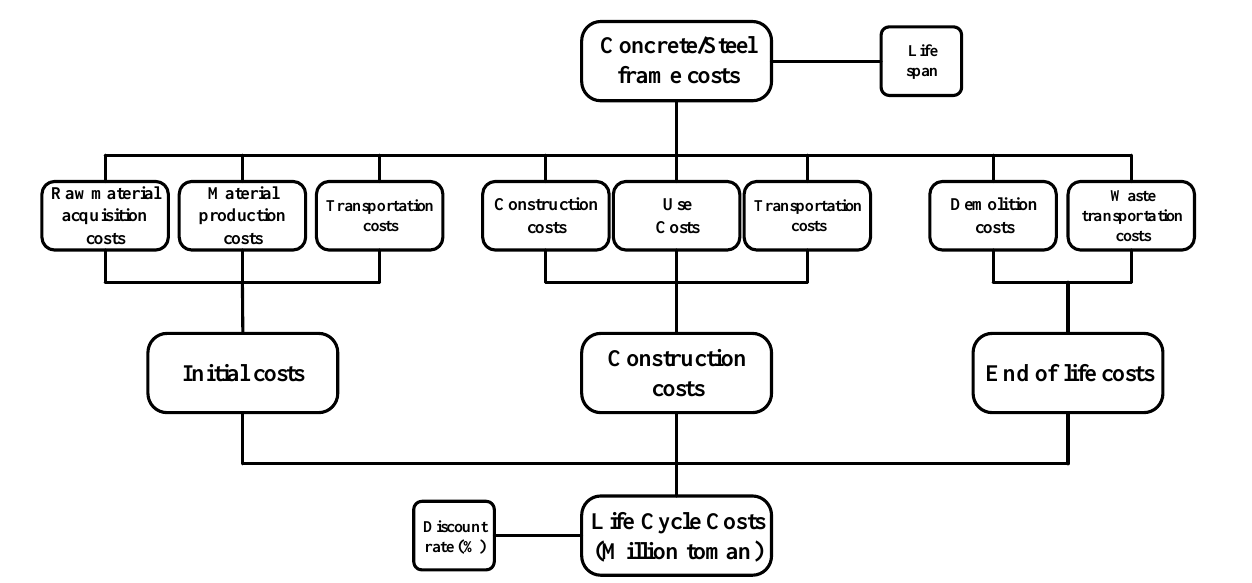
Figure 5. Cost Breakdown Structure. Table 2. NPV and EAC of the two frames during life cycle